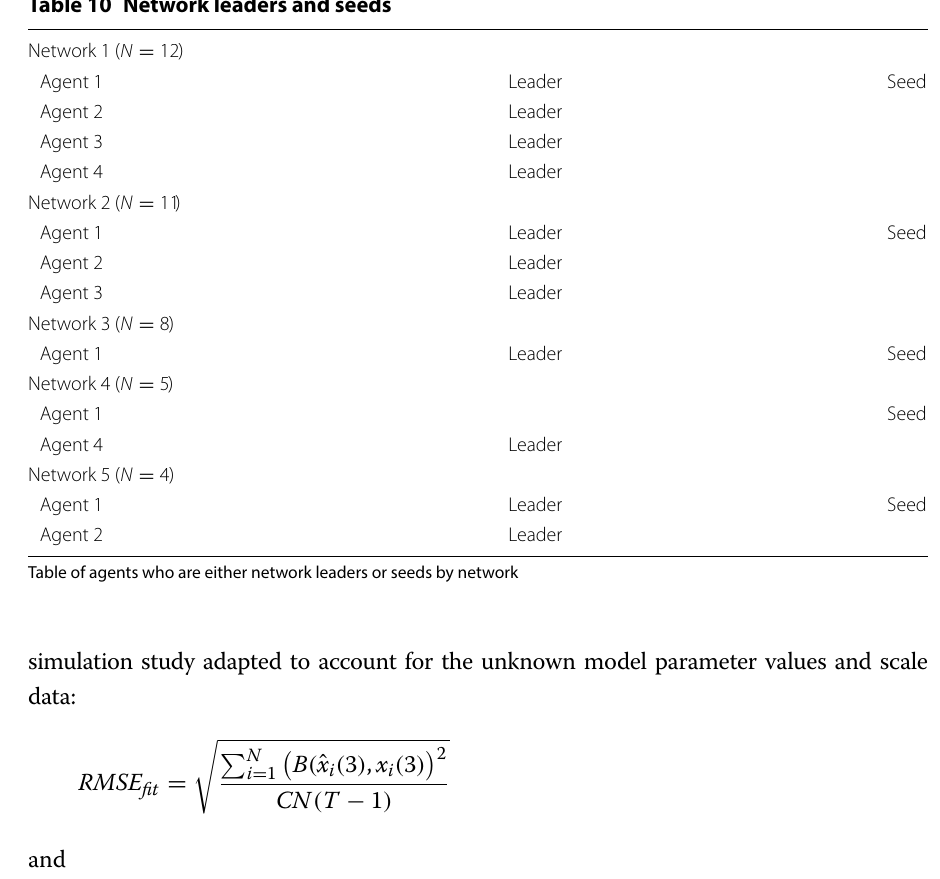
Table 10 Network leaders and seeds